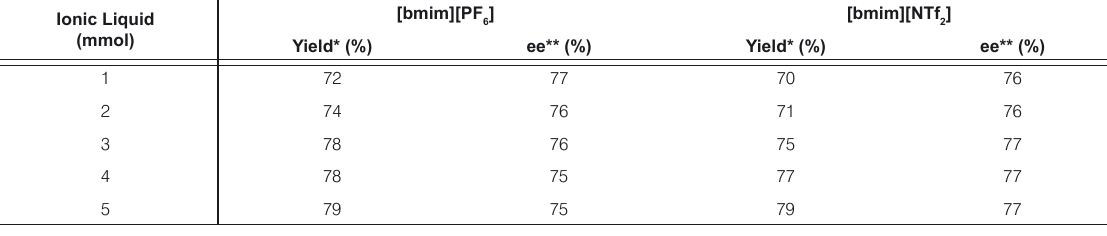
*Isolated yield after column chromatography, **Determined by HPLC Table 2. Organic solvent screening for sulphonimide 1 catalysed aldol reaction.